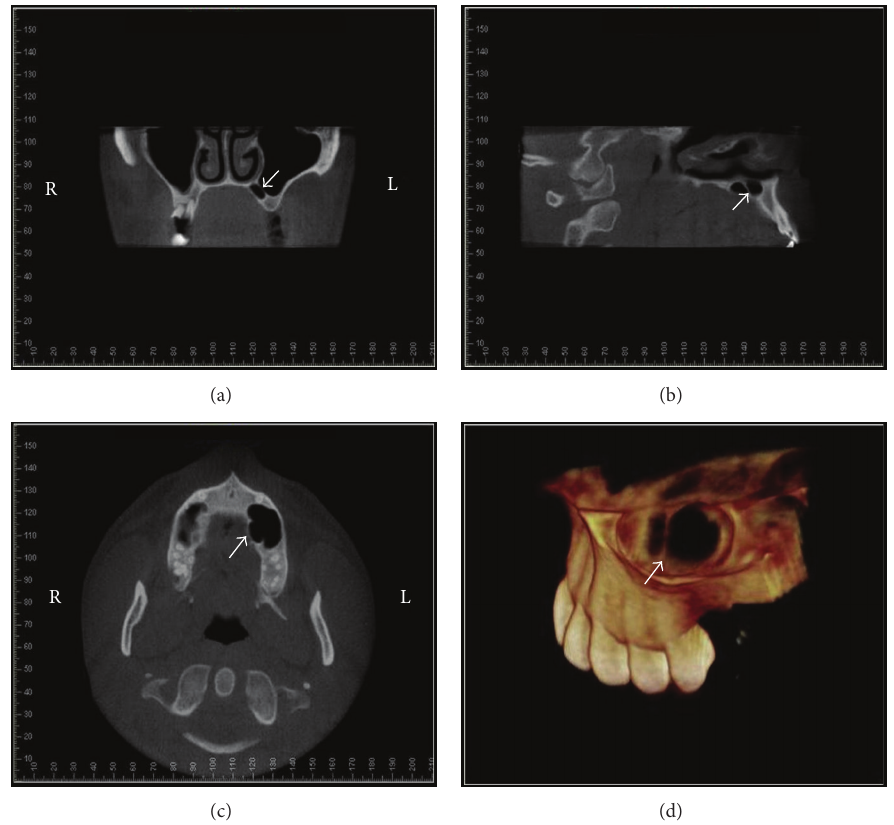
Figure 2: CBCT images: coronal (a), sagittal (b), and axial (c) slices and 3D reconstruction (d) in which the septum and palatine extension maxillary sinus are clearly seen on left side (arrows). R: right side and L: left